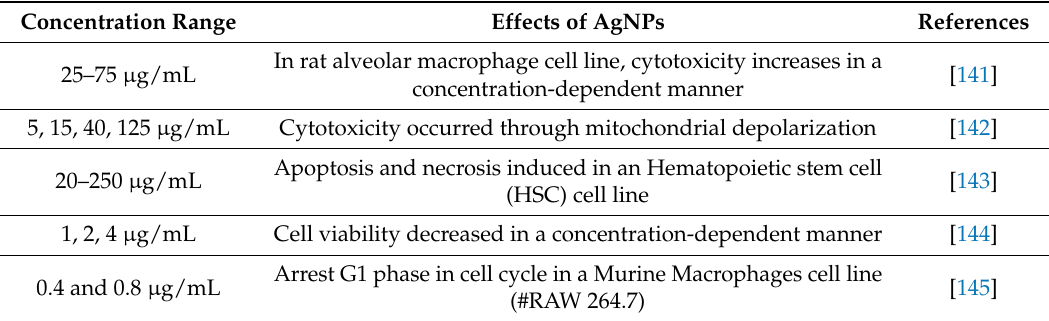
Table 2. Effects of Ag-NPs at different ranges of concentration on different cell lines. Adapted from [52], with permission from